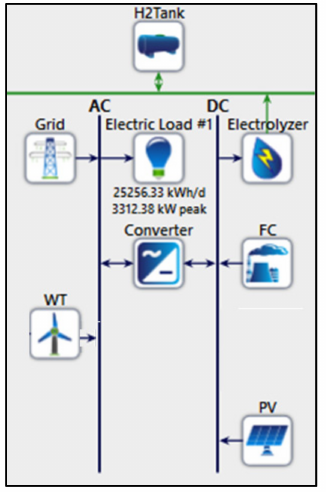
Figure 21. HOMER simulation model of the proposed HRES.